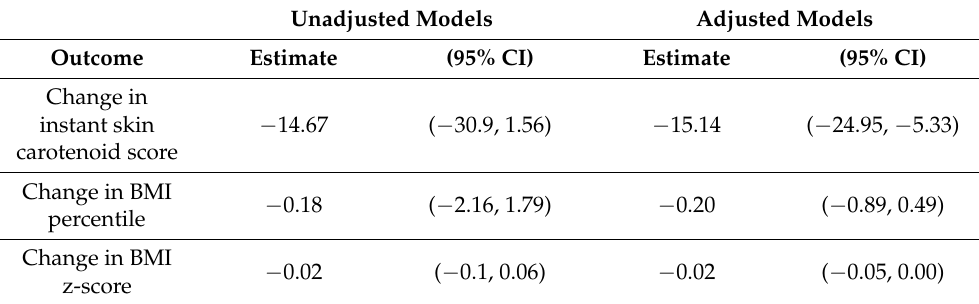
Table 4. Program effects on instant skin carotenoid score and BMI for Mexican-heritage